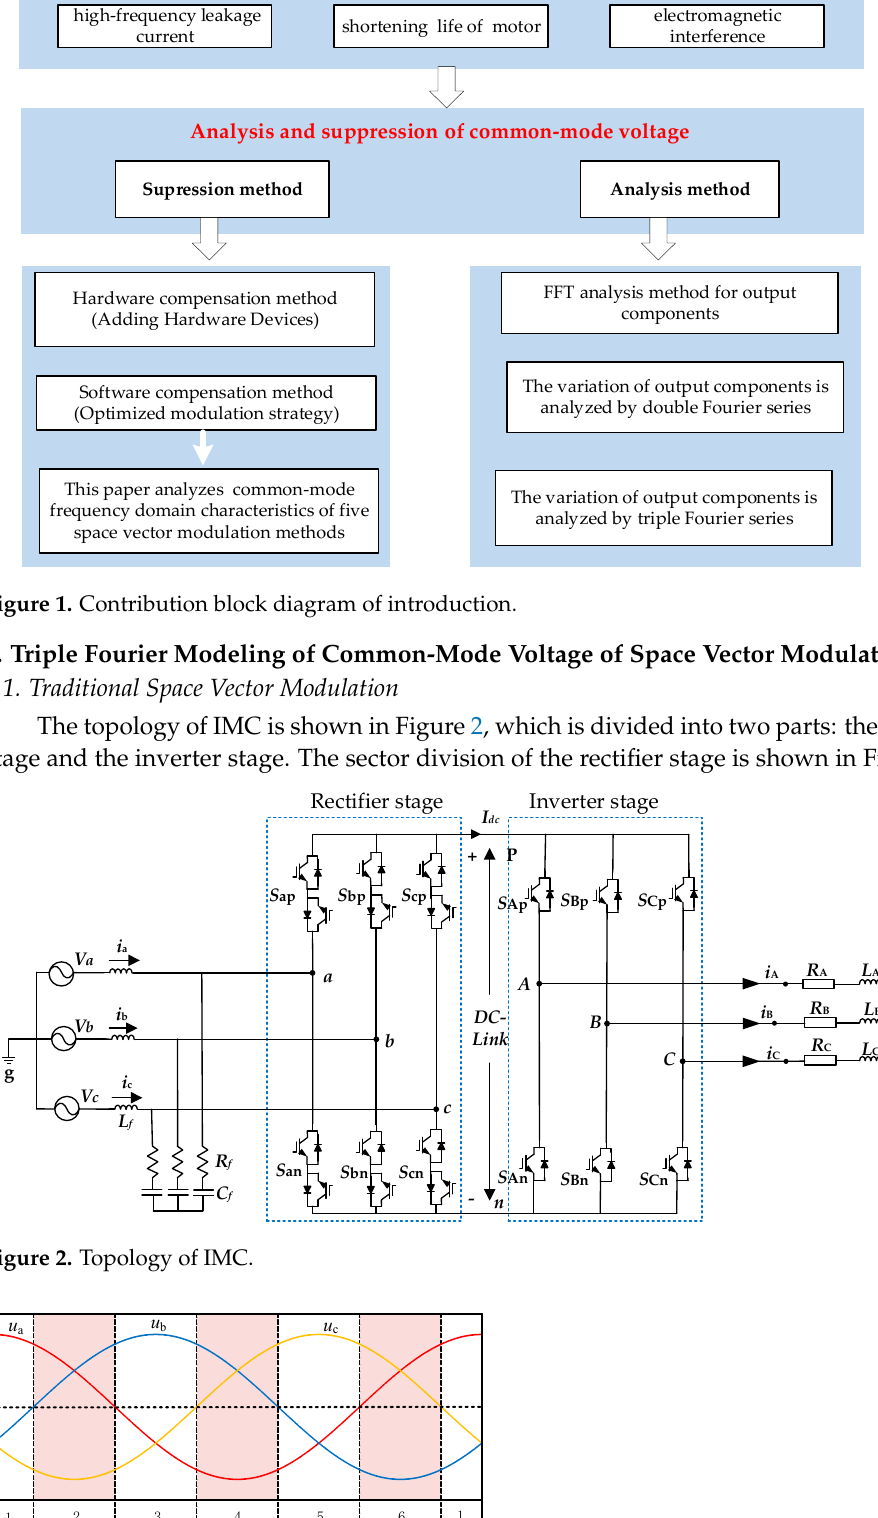
Figure 3. Sector of rectifier stage.